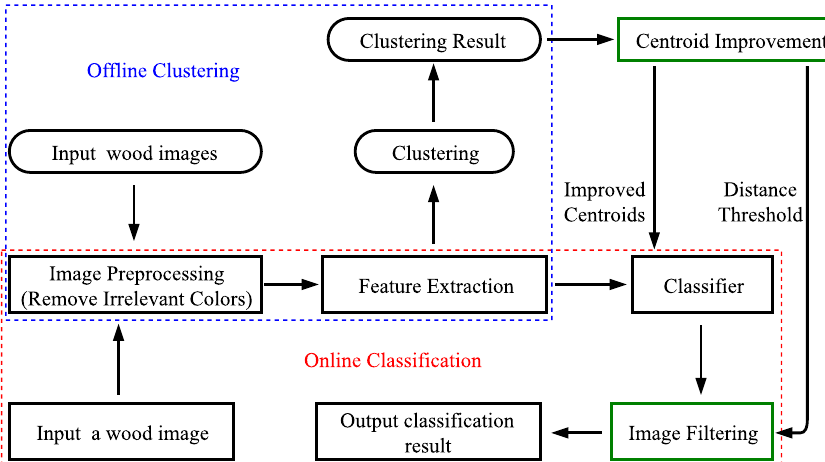
Figure 7. The framework of the color classification mechanism with abnormal wooden board